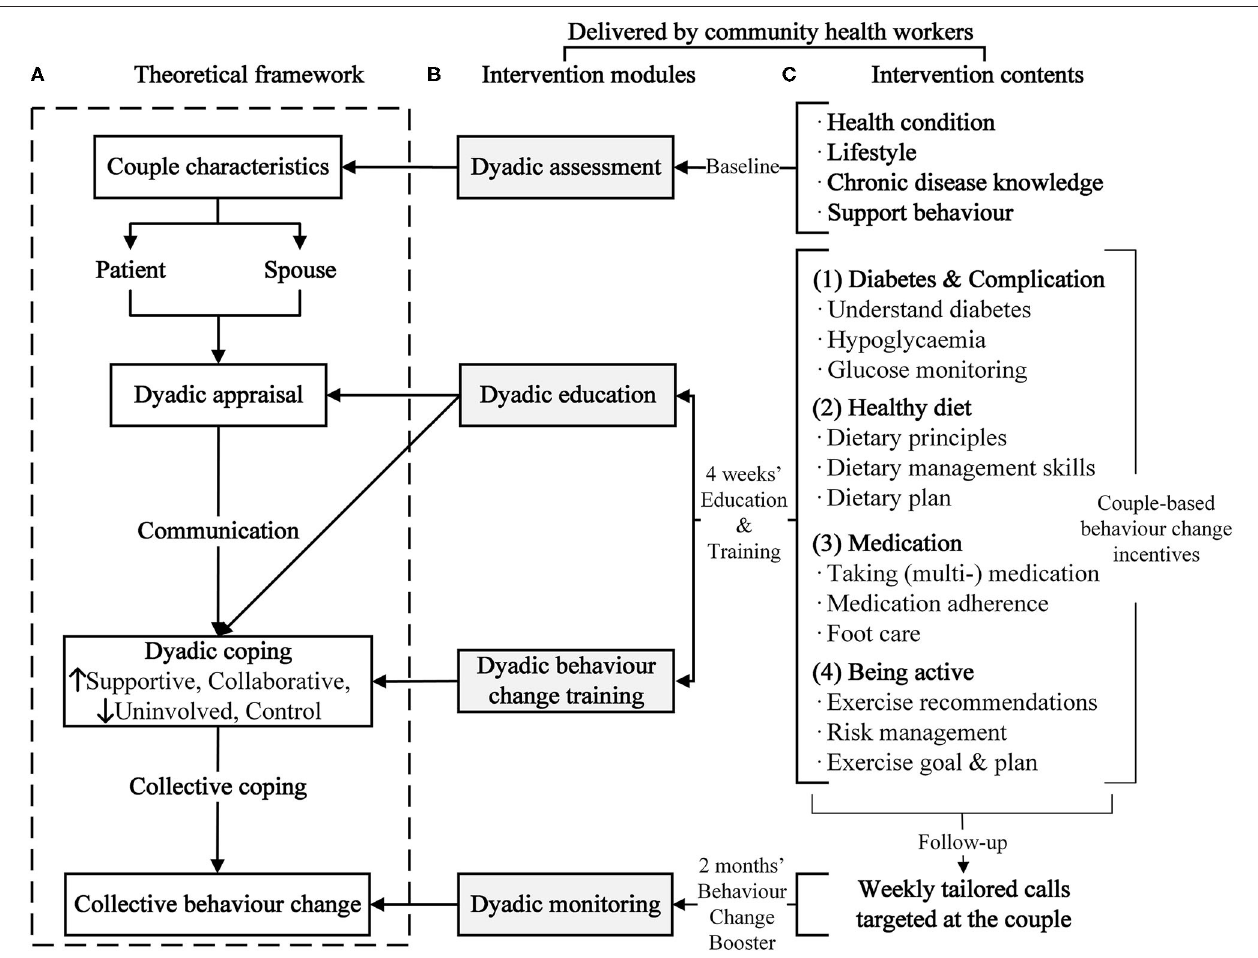
FIGURE 1 | Theoretical framework and modules of couple-based collaborative management model. (A) Theoretical framework. (B) Intervention modules. (C) Intervention